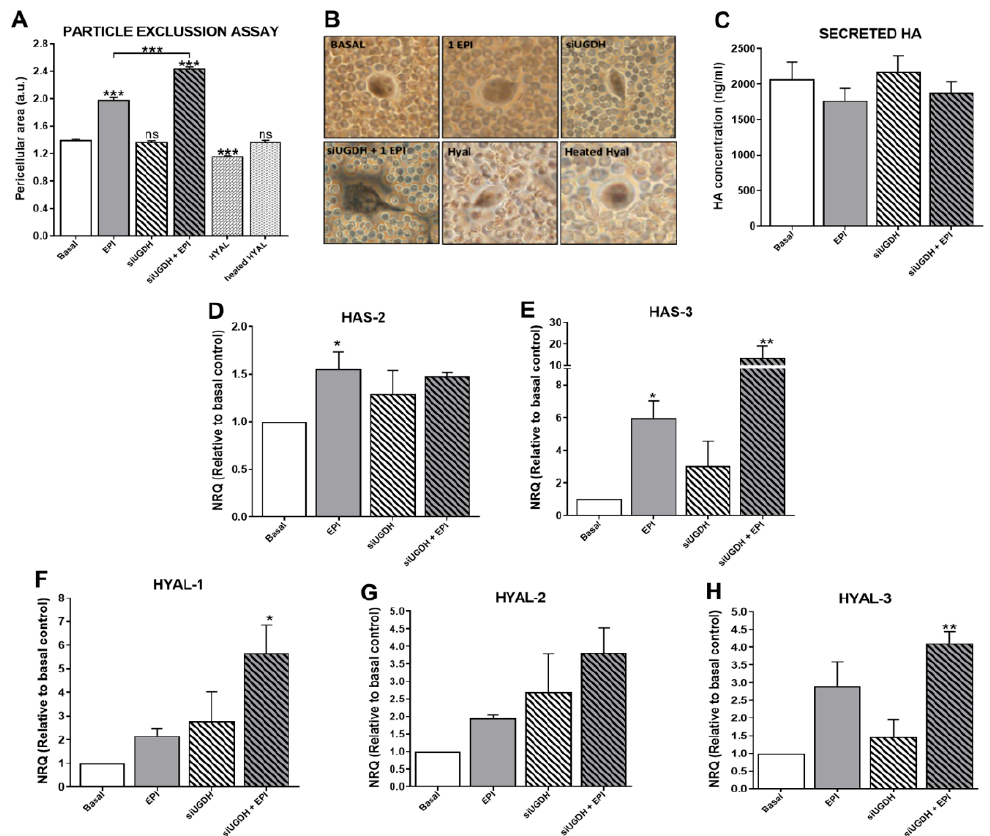
Figure 7. Evaluation of ECM variations as a consequence of silencing of UGDH and EPI treatment. MDA-MB-231 cells were transfected with a specific siRNA against UGDH (siUGDH) and a random sequence siRNA as the negative control (siSCR). After 24h, 1 μ M EPI (1 EPI) was added to complete 48 h of incubation. To perform the particle exclusion assay, 2 × 10 7 fixed red blood cells were added to each well. After allowing one to decant, multiple images were captured and analyzed using ImageJ software ( A ). Micrographs show the most representative of three independent experiments ( B ). Secreted HA in cell supernatants was measured by ELISA ( C ). HAS2 ( D ), HAS3 ( E ), HYAL-1 ( F ), HYAL-2 ( G ) and HYAL-3 ( H ) expressions were obtained by real-time quantitative PCR using SYBR Green or Taqman probes. Results were normalized using β -actin as the reference gene and all determinations were performed as duplicates. n = 3, mean ± SEM, * p < 0.05 ** p < 0.01 *** p <